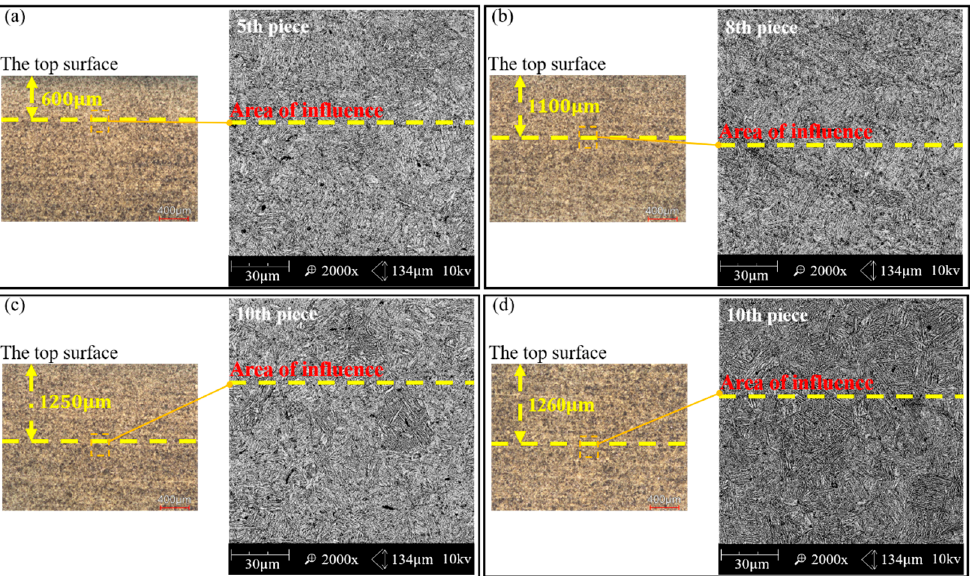
Figure 14. Thickness of the shock-affected layer of the specimen at different pulse energies ( a ) 6 J; ( b ) 8 J; ( c ) 10 J; ( d ) 12 J.